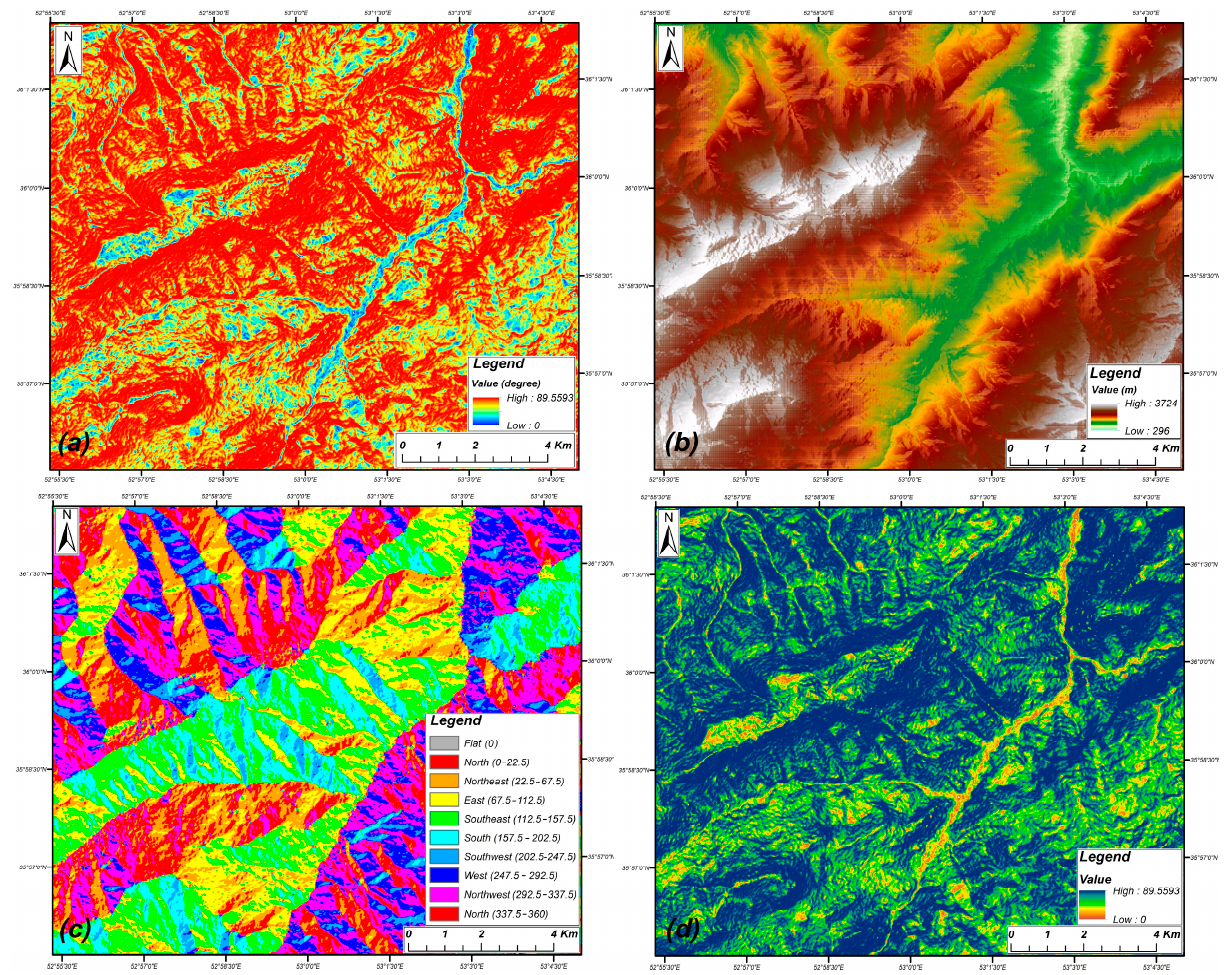
Figure 4. The geomorphologic/topographic triggering factors: ( a ) slope curvature, ( b ) topographical elevation, ( c ) slope aspect, and ( d ) weathering.